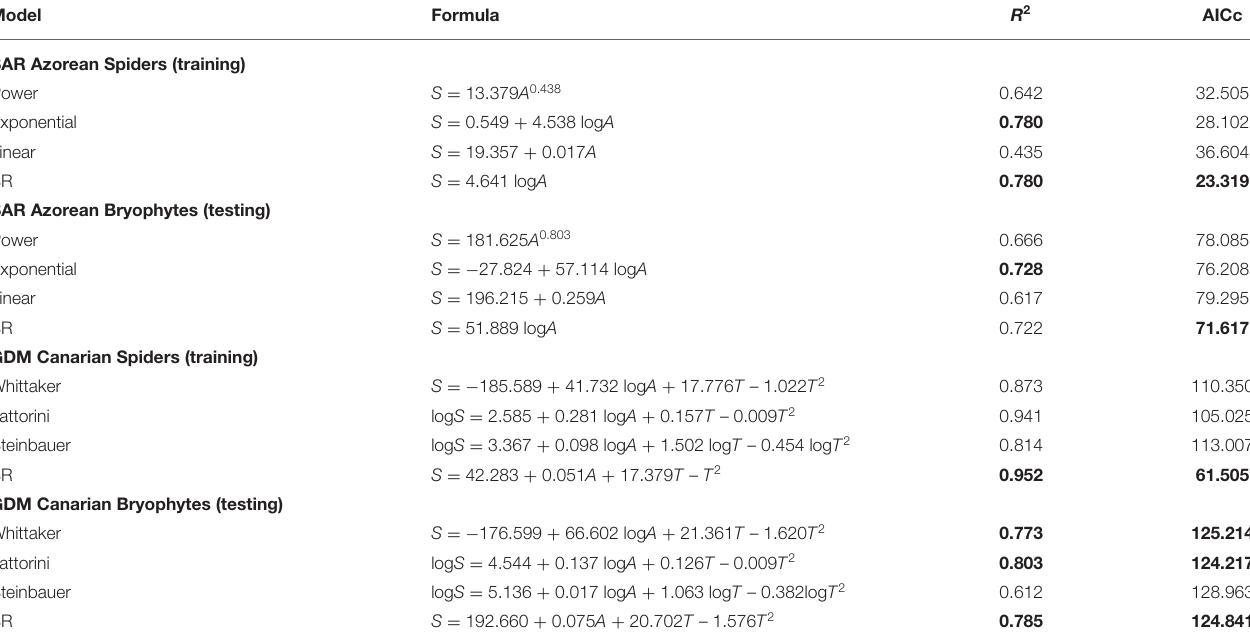
TABLE 4 | Species area relationship (SAR) models for Azorean taxa and General Dynamic Models (GDM) of oceanic island biogeography for Canarian taxa.